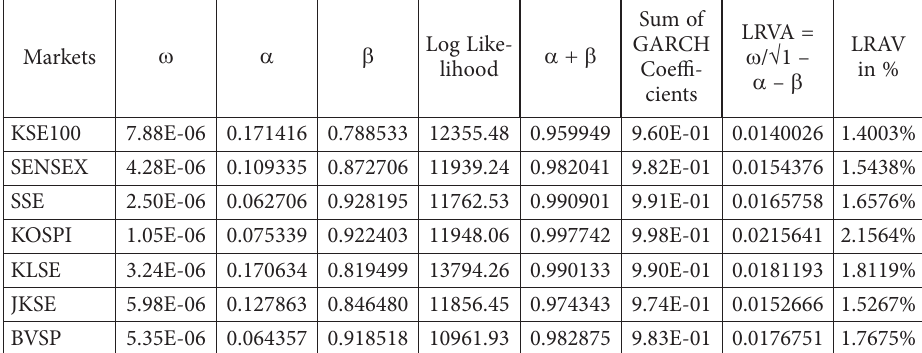
Table 7. Econometric analysis (GARCH Coefficients) for emerging